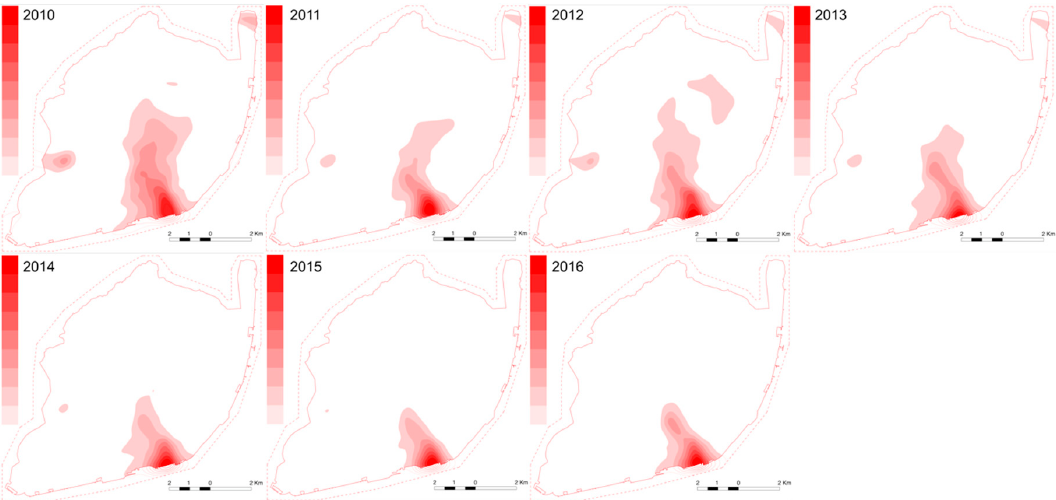
Figure 9. Yearly Dual KDE of issued permits for building renovation in the 2011–2016 period in the city of Lisbon. h = 3150 m Source: Authors.